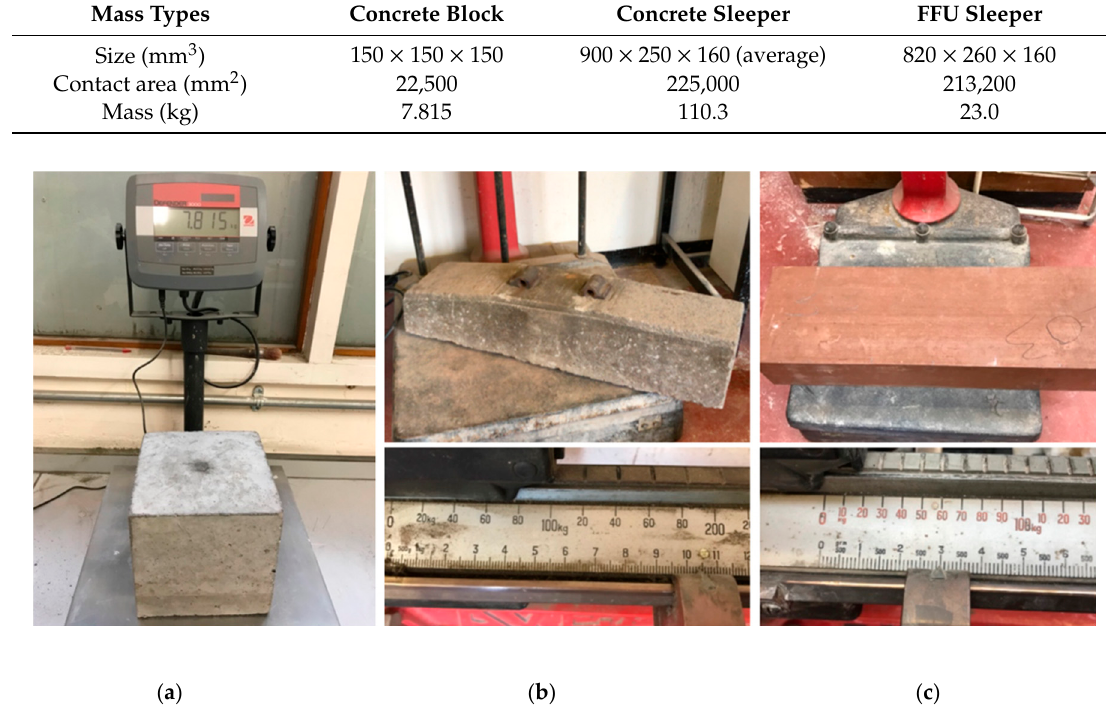
( b ) Figure 5. ( a ) The impact hammer; ( b ) acquisition device with DATs software. ( a ) ( b )